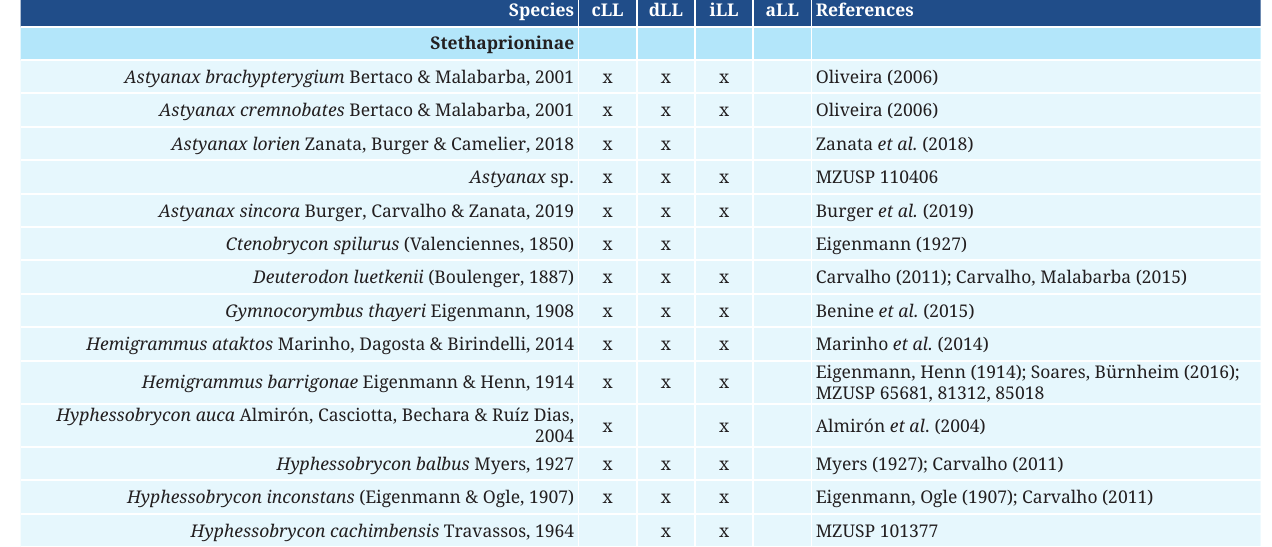
TABLE 2 | Species of Characidae with intraspecific variation in the lateral line trunk morphology. Classification of genera and subfamilies follows Mirande (2018). Burger et al . (2019) reported variation in the completeness of the lateral line in Astyanax epiagos Zanata & Camelier, 2008, Deuterodon hastatus (Myers, 1928) and D. ribeirae (Eigenmann, 1911), but specific condition were not mentioned by the authors. LL = lateral line, c = complete, d = discontinuous, i = incomplete, a =